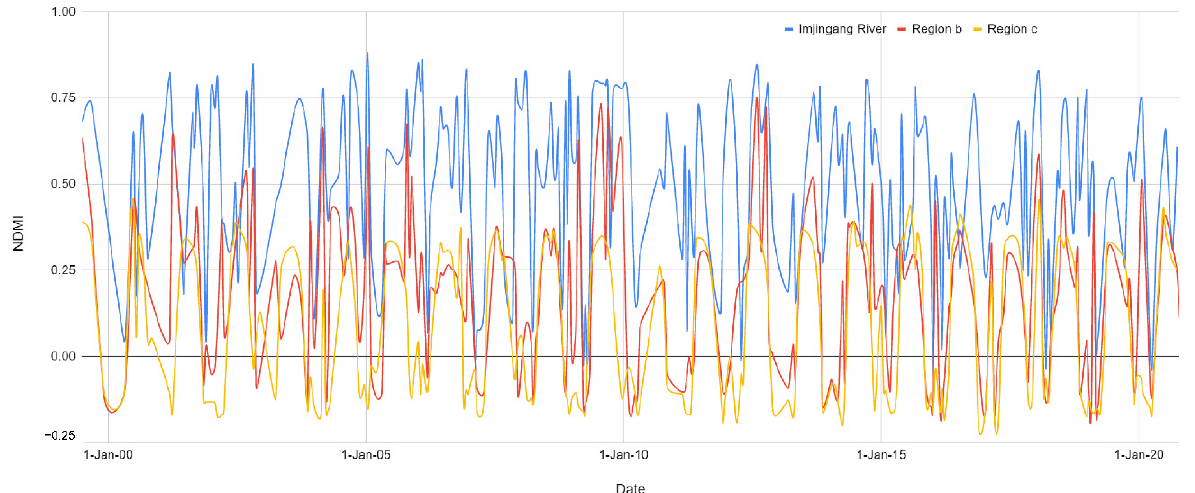
Figure A4. Time-series pattern of NDMI in the DMZ. Red line, NDMI of Region b in Figure 7b; wetland was maintained by water fluctuation. Yellow line, NDMI of Region c in Figure 7c; frequent fires occurred in the grassland. Blue line, NDMI of Imjingang River, which is the baseline. Data were analyzed from 1999 to 2020 using Landsat 7. NDMI of wetlands appeared to be affected by flooding caused by river overflows. NDMI was calculated using the Google Earth Engine.